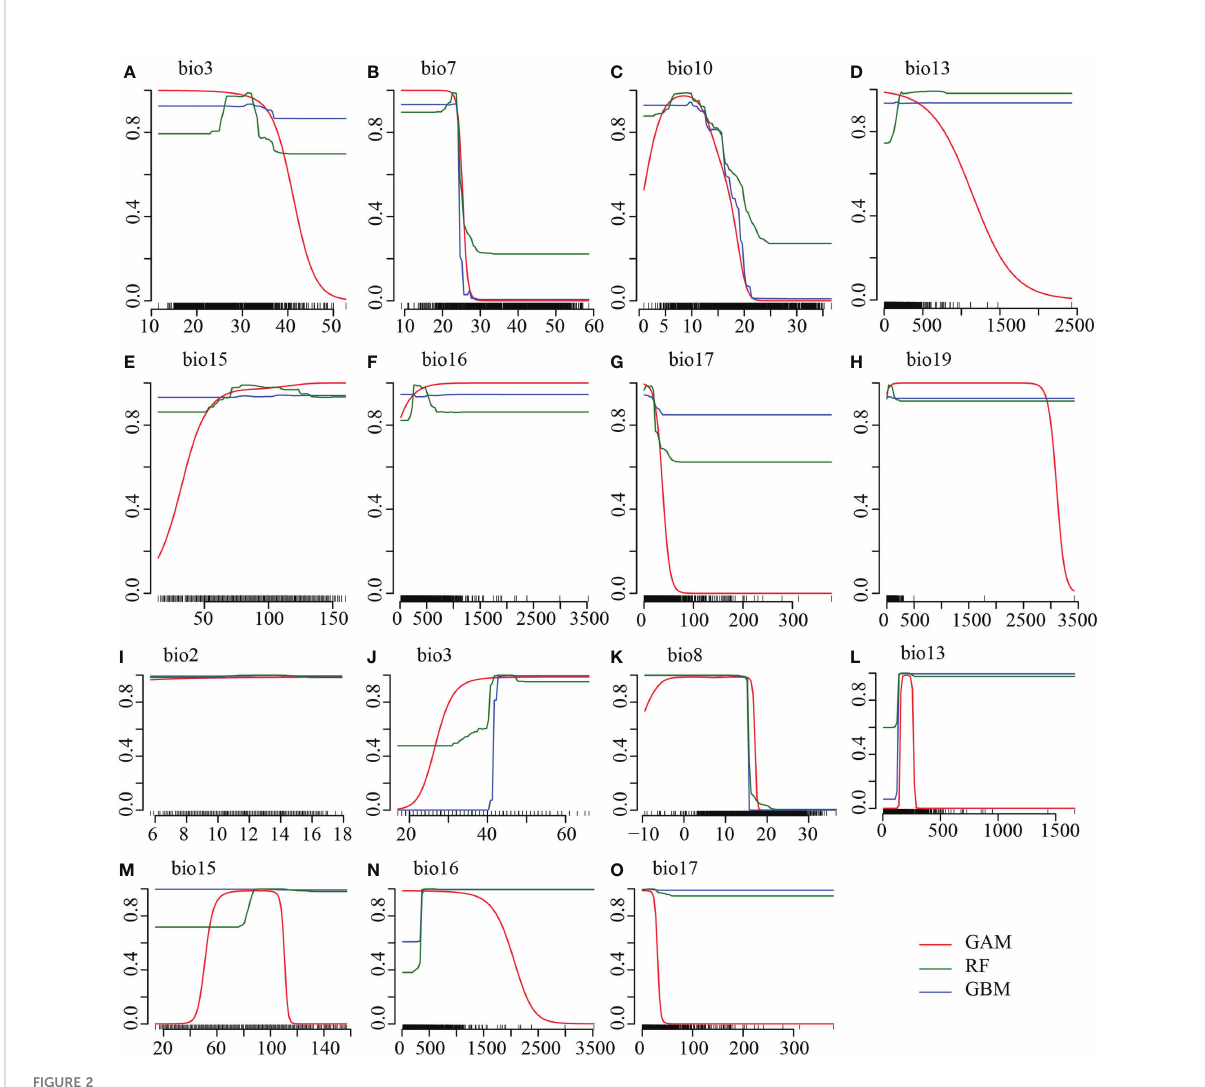
FIGURE 2 Response curves of the highly predictive top three algorithms showing the probability of presence (y-axis) under the (A – C, I – K) temperature- dependent and (D – H, L – O) precipitation-dependent variables (x-axis) for (A – H) Rheum nobile and (I – O) Rheum alexandrae . The predictive algorithms are the Generalised Additive Model (GAM; red line), Generalised Boosting Models (GBM; blue line), and Random Forest (RF; green line), with high model accuracy TSS > 0.9. Temperatures are expressed in °C (degree Celsius) and precipitation in mm (millimeter). Refer to Table 1 for the bioclimatic